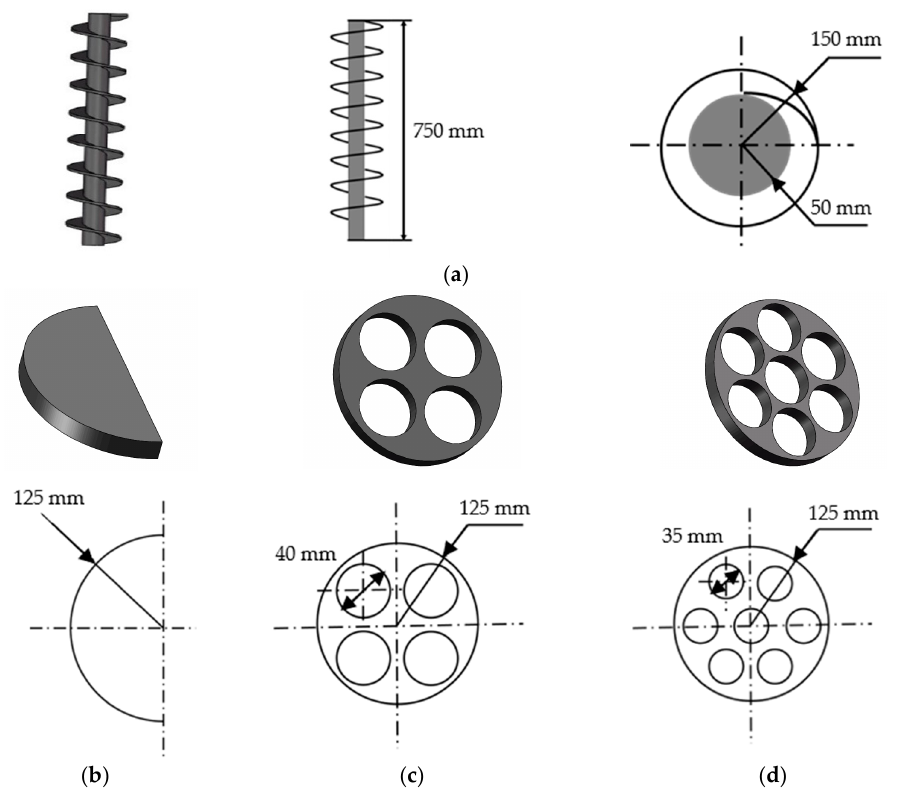
Figure 4. Model diagram of coalescing components. ( a ) Spiral track model diagram; ( b ) semicircular baffle model diagram; ( c ) four-hole plate model diagram; and ( d ) seven-hole plate model diagram. Fluent’s preprocessing module Gambit is used to model discrete pipes with different coalescing components. The discrete pipe adopts the division method of global control and local encryption. Tetrahedral mesh is used to partition the whole area, and unstructured mesh is used only in the local complex area. The coalescing components are divided by unstructured mesh, and the rest of the riser is divided by tetrahedral mesh. The velocity boundary condition is set at inlet, the outflow is set at the outlet, the wall boundary condition is set on pipe surface. Figure 5 shows the mesh division.